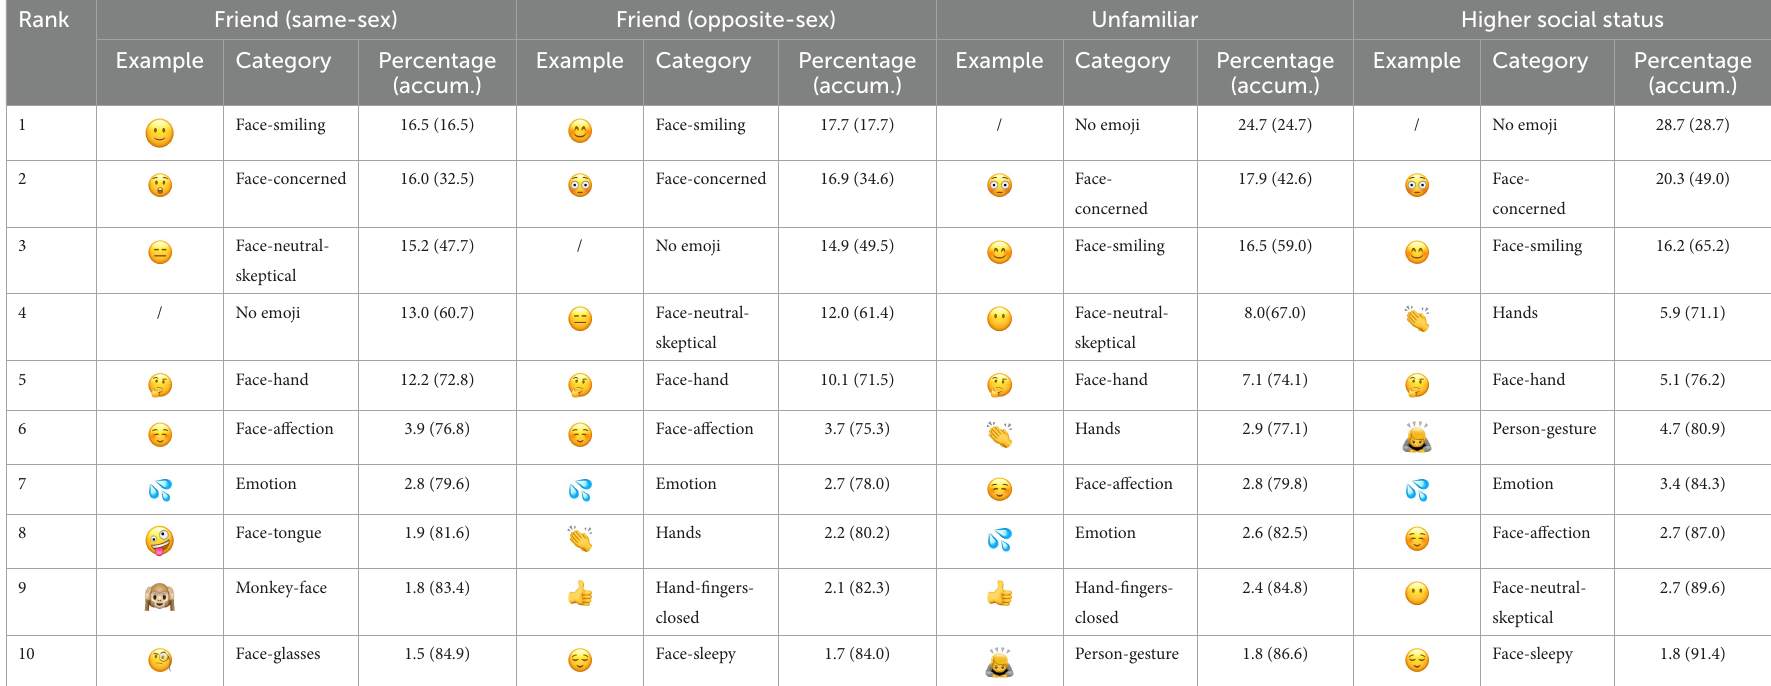
TABLE 3 Most used emoji categories with different targets (interactor won a